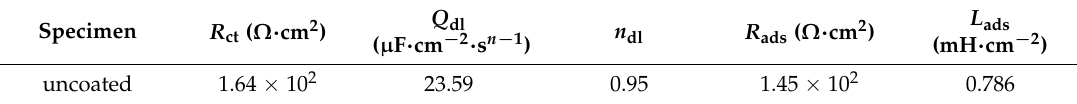
Table 3. The EIS simulation results for the uncoated AZ31B Mg alloy tested in 3.5% NaCl solution.